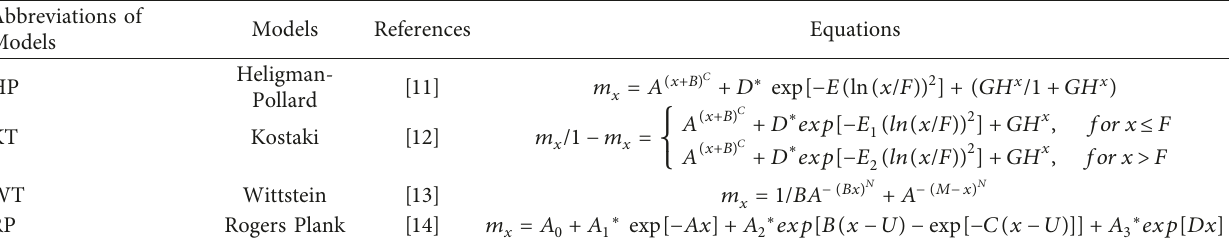
Table 2: List of parametrized mortality models, acronyms, and